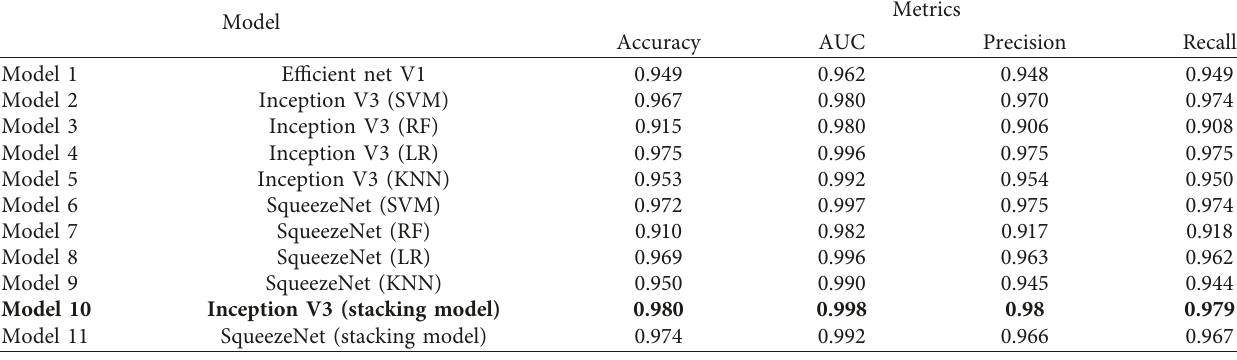
Table 6: Model metrics assessment with stacking